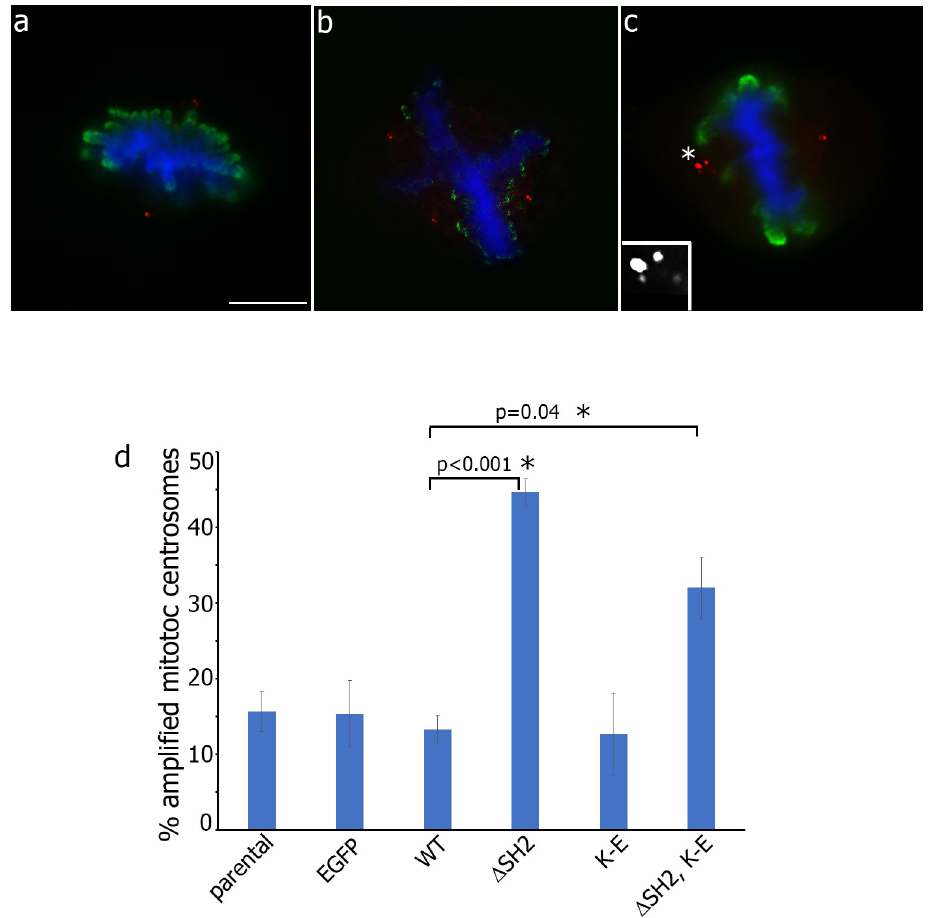
Fig 8. JAK2 regulates centrosome amplification and the SH2 domain of JAK2 is required for that. Parental COS-7 cells and stable COS-7 clones were fixed, stained with DAPI (blue) and immunolabeled with anti-pHistone H3 (green) for assessment of mitotic cells only. Centrosomes were immunolabeled with anti-centrin 1 (red). The cells were scored for ( a ) normal mitosis with � 2 centriolar pairs, mitosis with amplified centrosomes ( > 2 centriolar pairs), including multipolar mitosis ( b ) and mitosis with clustered centrosomes ( c ). The inset in (c) shows enlarged centrosomes. ( d ) The graph shows the percentage of cells with amplified centrosomes (50 mitotic cells per experiment, 3 independent experiments for each cell clone and parental cells). Bars represent mean ± SE. � , P < 0.05 compared with WT cells. Scale bar 8 μ m.